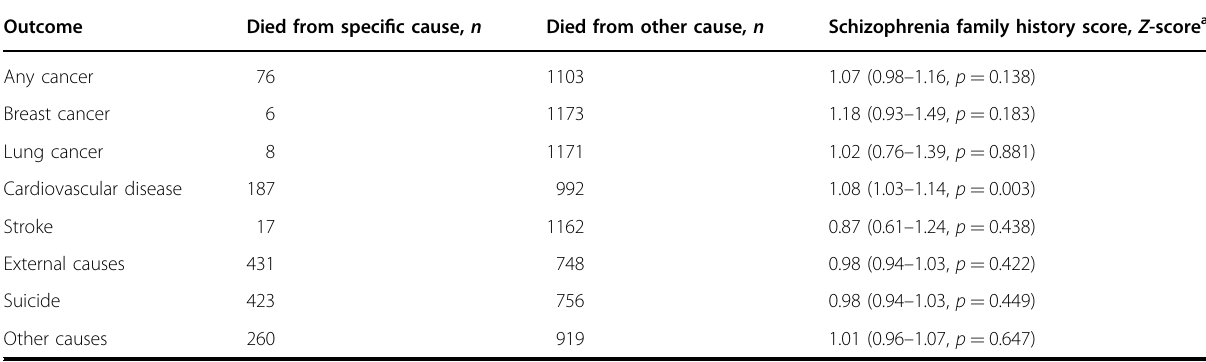
Table 2 Cox proportional hazards modelling of schizophrenia family history in association with speci fi c causes of death in population-based sample of Swedish cases of schizophrenia (Population-based cohort, n = 1179 SCZ cases who died).